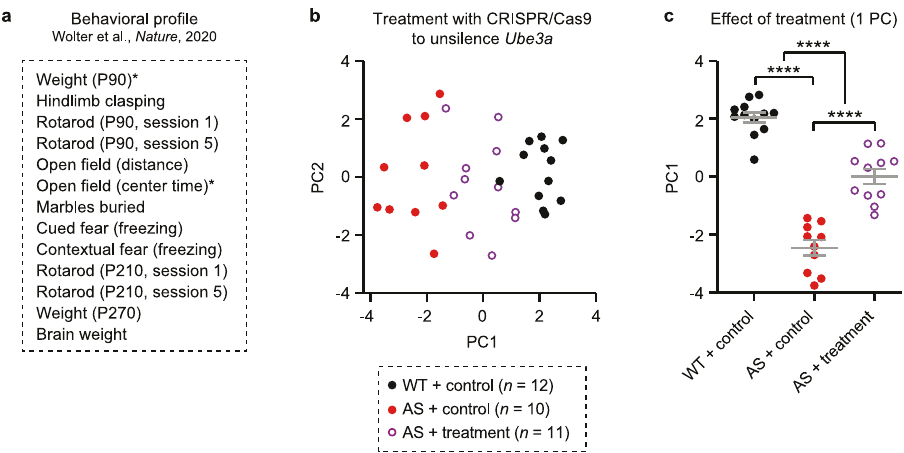
Fig. 6 Multidimensional analysis has the sensitivity to detect behavioral improvement in Ube3a m-/p + mice following treatment. a Multidimensional analysis used 12 behavioral measures from Wolter et al. (Dataset 3). *Indicates sex difference and standardization by sex. b Animals with paternal Ube3a unsilencing (purple open circles) have a qualitatively intermediate behavioral pro fi le between Ube3a m-/p + mutants (AS; red) and wild-type controls (WT; black). c In 1PC space, treated AS mice show overall behavioral improvement relative to control AS mice, but not full rescue. Full timeline of behavioral tests and analysis using different combinations of behavioral tests is shown in Fig. S11. Data represent mean ± SEM ; **** p <